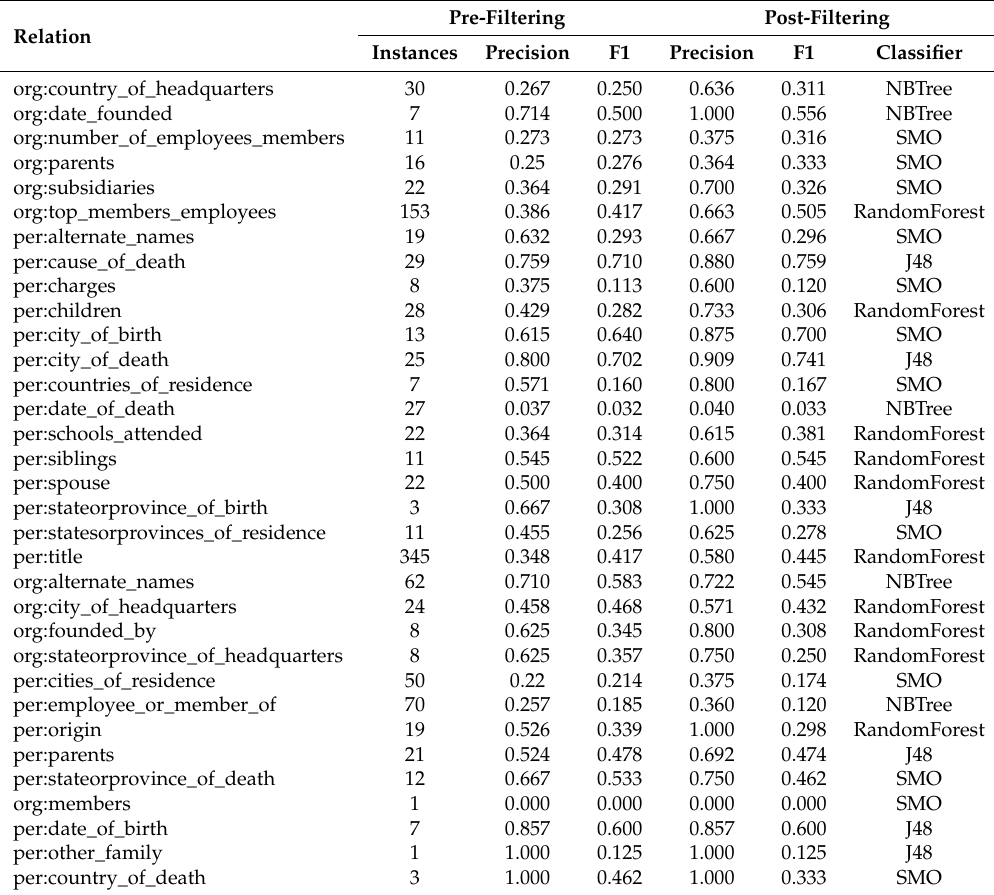
Table 5. Evaluation for Relation Factory using the TAC KBP 2013 Slot Filling scorer on the test dataset before and after filtering for each relation.